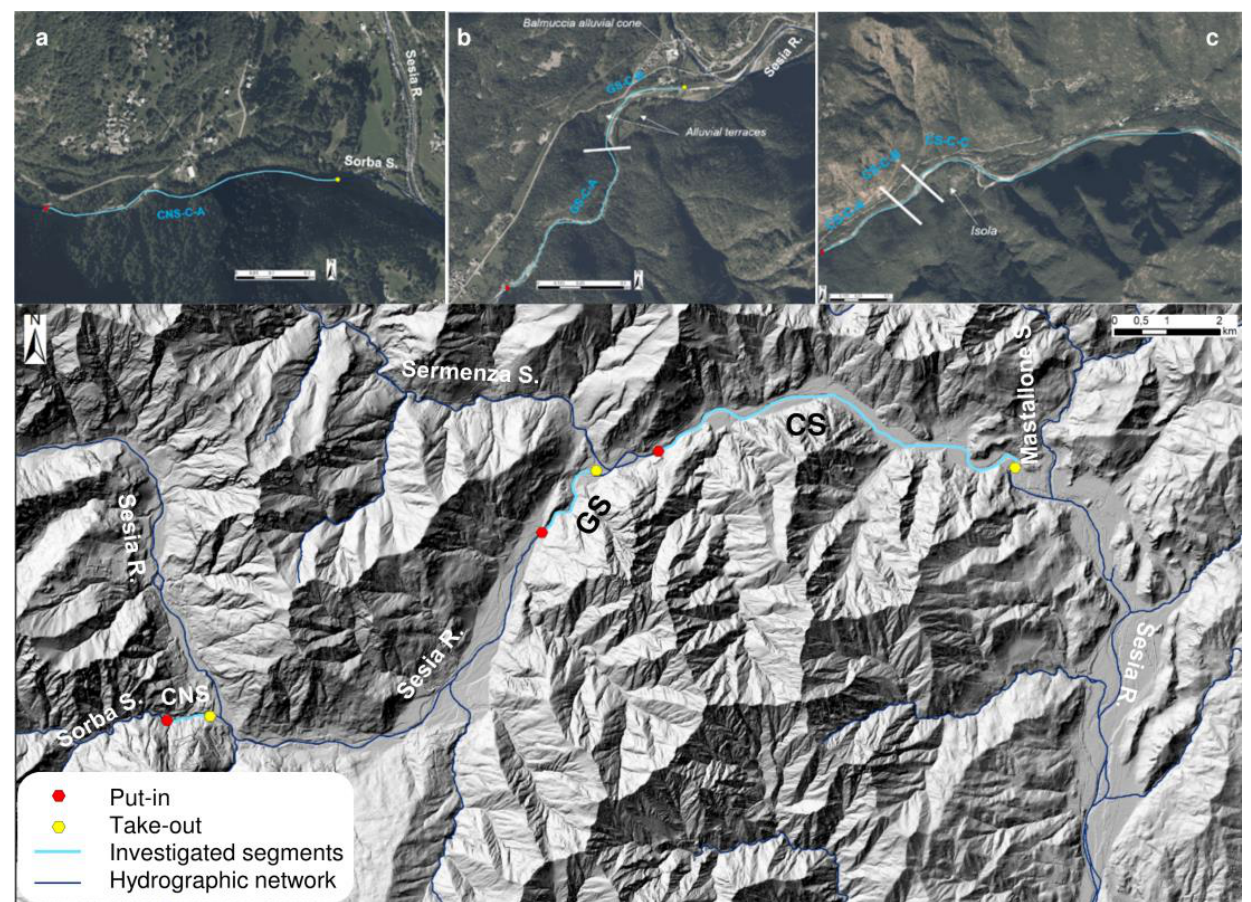
Figure 5. The subdivision in reaches according to the confinement of the investigated segments of Canyoning Sorba ( a — CNS), Gole del Sesia ( b — GS), and Classico del Sesia ( c — CS). The white short lines transversal to the Sesia river are the limits of the CS and GS reaches, according to the confinement. Background of the a, b, and c images: aerial photograph © AGEA 2018. The hillshade below is derived from the Digital Elevation Model (5 m resolution, © Geoportale Regione Piemonte). The location of traits within the UGGp is reported in Figure 2.